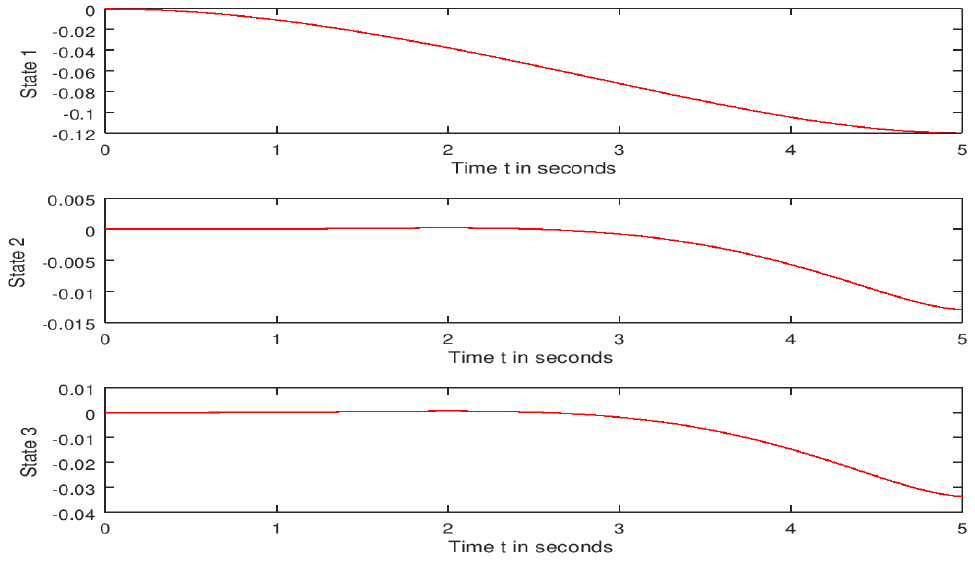
Figure 4. Feasible first three state functions.